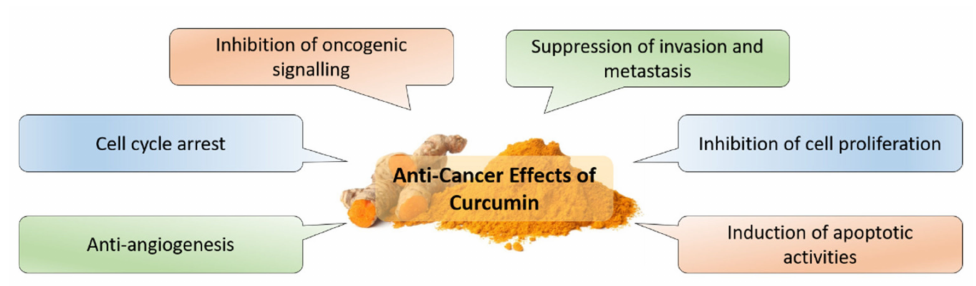
Figure 2. Curcumin elicits various anticancer effects in cancer